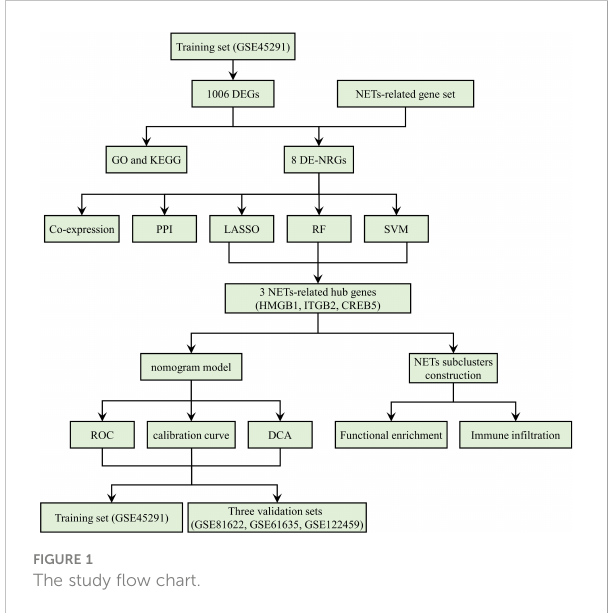
FIGURE 1 The study fl ow chart.